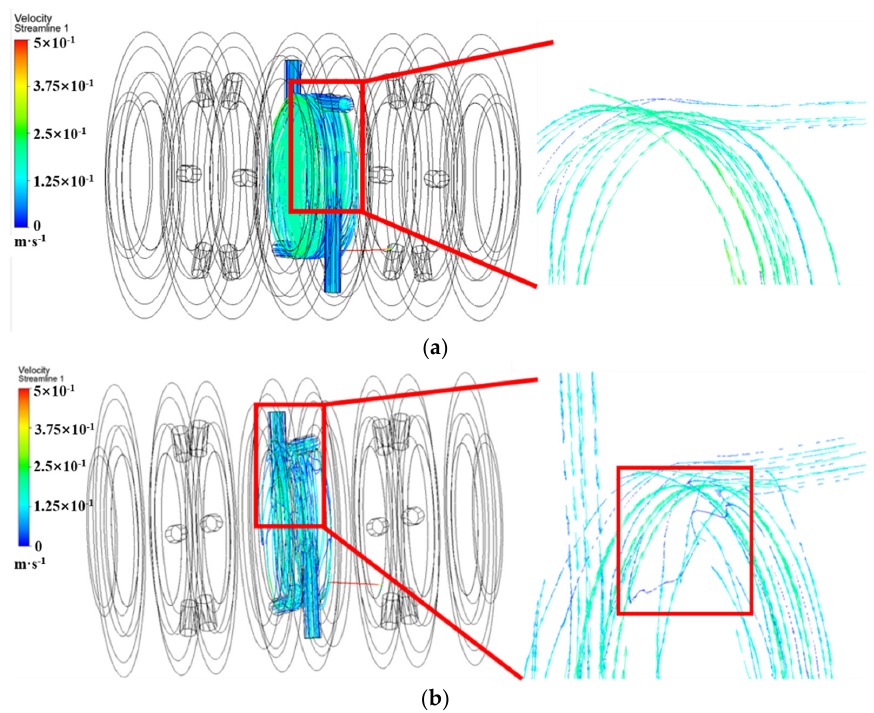
Figure 9. Flow-line diagram in the middle chamber. ( a ) The air-inlet direction is the same as the spindle-rotation direction; ( b ) the air-inlet direction is opposite to the spindle rotation direction. The flow diagrams of the middle chamber in both intake directions show that the flow lines are uniform and stable when the air-inlet direction is the same as the spin- dle-rotation direction. However, when the air-inlet direction is opposite, the intermedi- ate cavity-flow lines are chaotic and reverse-flow occurs near the intake port. This affects the subsequent intake and makes the middle-chamber airflow unstable. The temperature-field contour and pressure contour, in the main leakage channel, are shown in Figure 10. ( a ) ( b ) Figure 10. Finite-element analysis contour. ( a ) Temperature-field contour; ( b ) pressure-field con- tour.